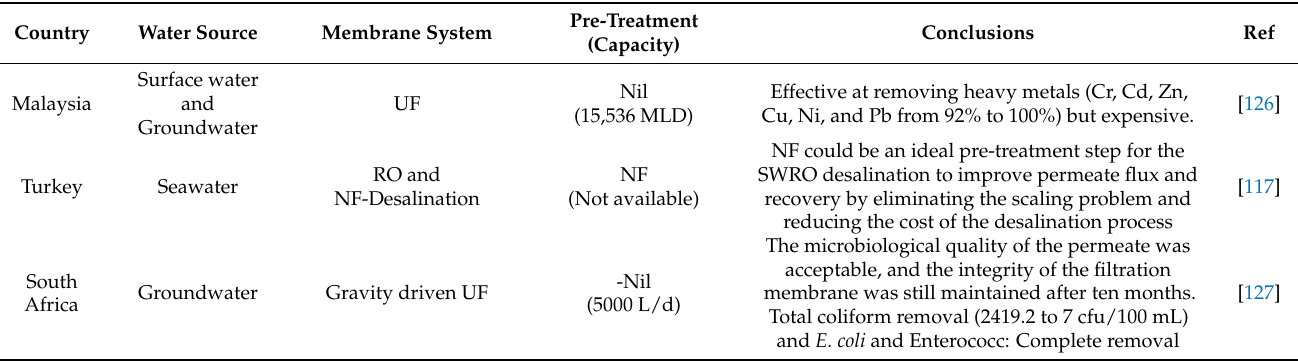
Table 2. Membrane system used in developing